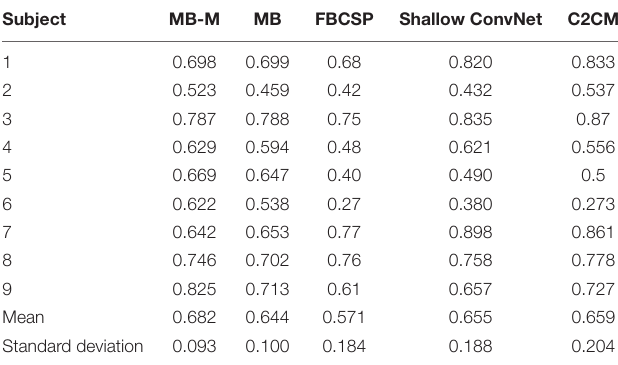
TABLE 3 | Comparison of the kappa value with the state-of-the-art